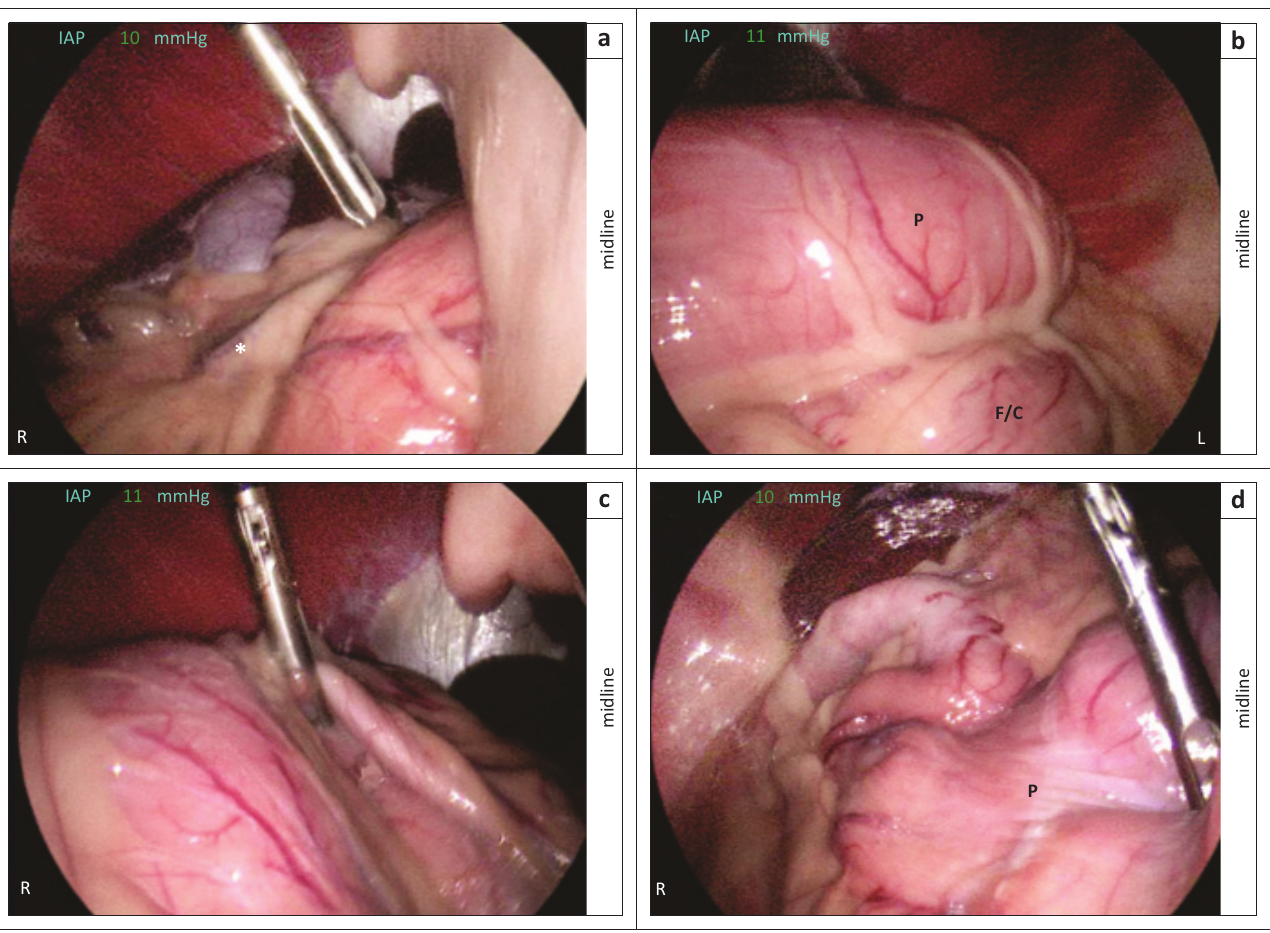
FIGURE 3: Laparoscopic image of the (a) right cranial peritoneal cavity precorrection, (b) left peritoneal cavity precorrection, (c) right peritoneal cavity and (d) image of normal position of the stomach in the right cranial peritoneal cavity after repositioning. Note the right cranial peritoneal cavity (a) illustrating the out-of-position splenic edge covered by omentum ( * ); the left peritoneal cavity (b) demonstrating a fold between pyloric part (P) and fundus or corpus (F/C) parts of the stomach; the right peritoneal cavity (c) demonstrating repositioning of the stomach with non-traumatic Babcock forceps; the normal position of pyloric part (P) of the stomach in the right cranial peritoneal cavity (d) after